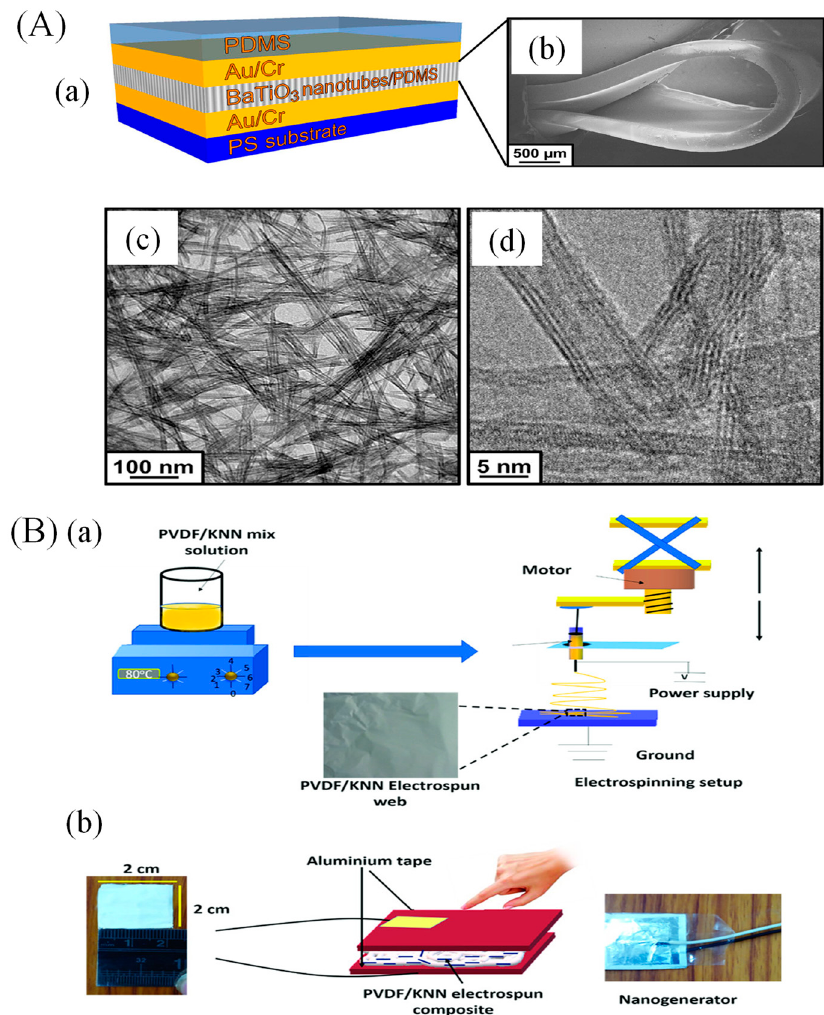
Figure 5. ( A ) BaTiO3-based flexible and transparent nanogenerator. ( a ) Schematics of the as-developed BaTiO3-based PENG. ( b ) SEM image of BaTiO 3 nanotube/PDMS composite. ( c ) TEM image of the synthesized BaTiO 3 nanotubes. ( d ) High-resolution TEM image of synthesized BaTiO 3 nanotube [70]. Adapted with permission from Lin et al. (2012). Copyright © 2012 American Chemical Society. ( B ) ( a ) Fabrication of PVDF/KNN NR film via the electrospinning method. ( b ) Fabrication of